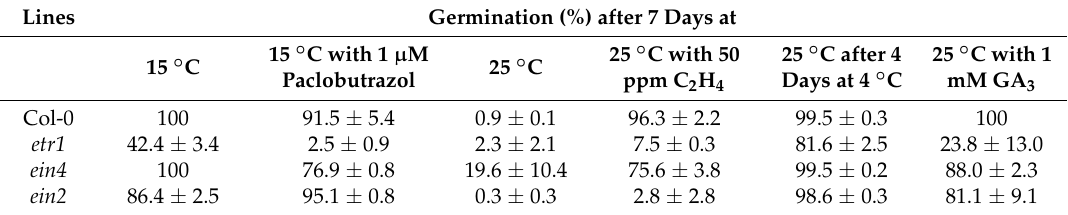
Table 1. Germination percentages obtained after seven days at 15 and 25 °C, at 15 °C in the presence of the paclobutrazol (1 μ M) and at 25 °C in the presence of ethylene 50 ppm, GA 3 1 mM and after four days of incubation at 4 °C. Means of 3 replicates ± SD. Seeds harvested in 2014. Lines